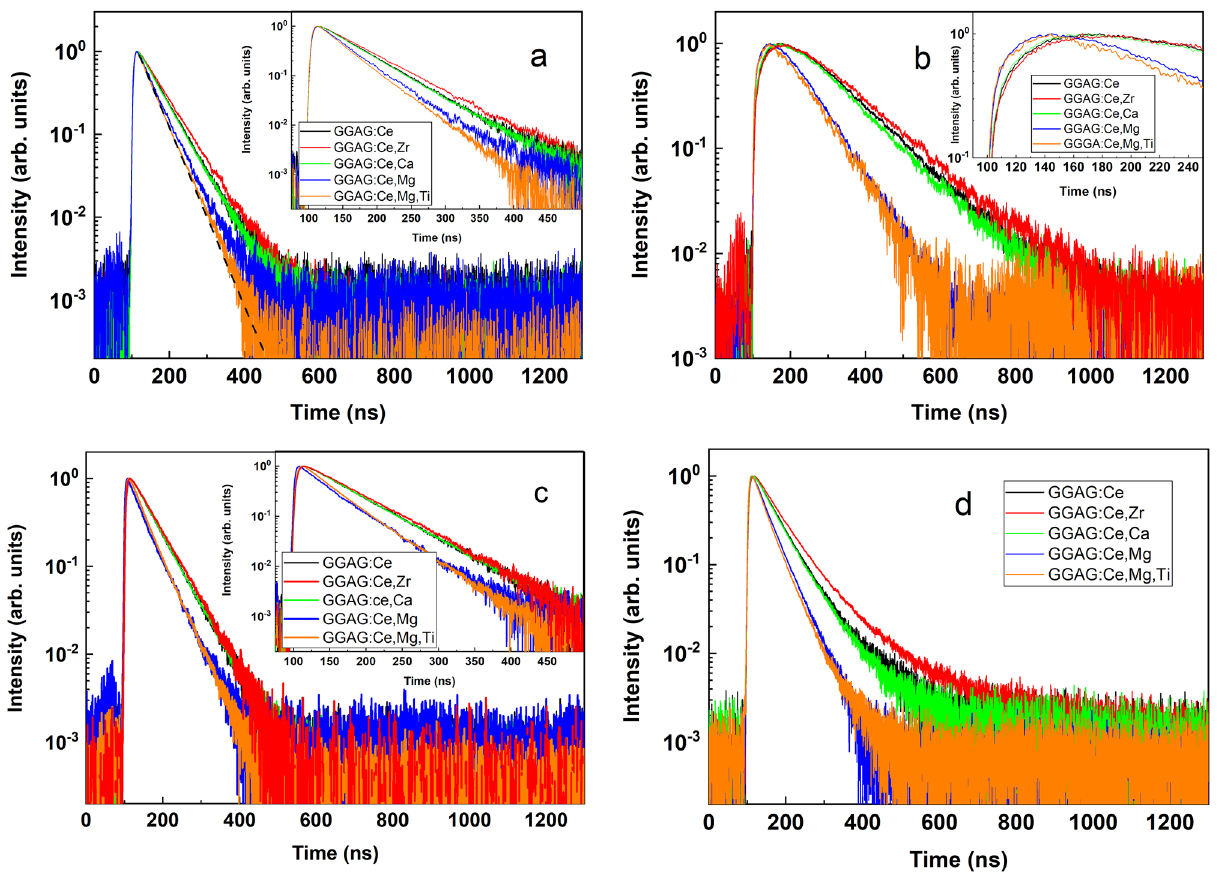
Figure 6. Luminescence decay kinetics of the Ce 3+ emission (530 nm) in the co-doped GGAG:Ce single crystals under 450 nm ( a ), 275 nm ( b ), 235 nm ( c ) and 210 nm ( d ) excitations at room temperature. Black dashed line in ( a ) demonstrates an example of single exponential fit if the parameter of the decay time constant is 40 Fig. 6c under the 235 nm excitation. Again, the luminescence decay kinetics are faster for the Mg 2+ and Mg + Ti